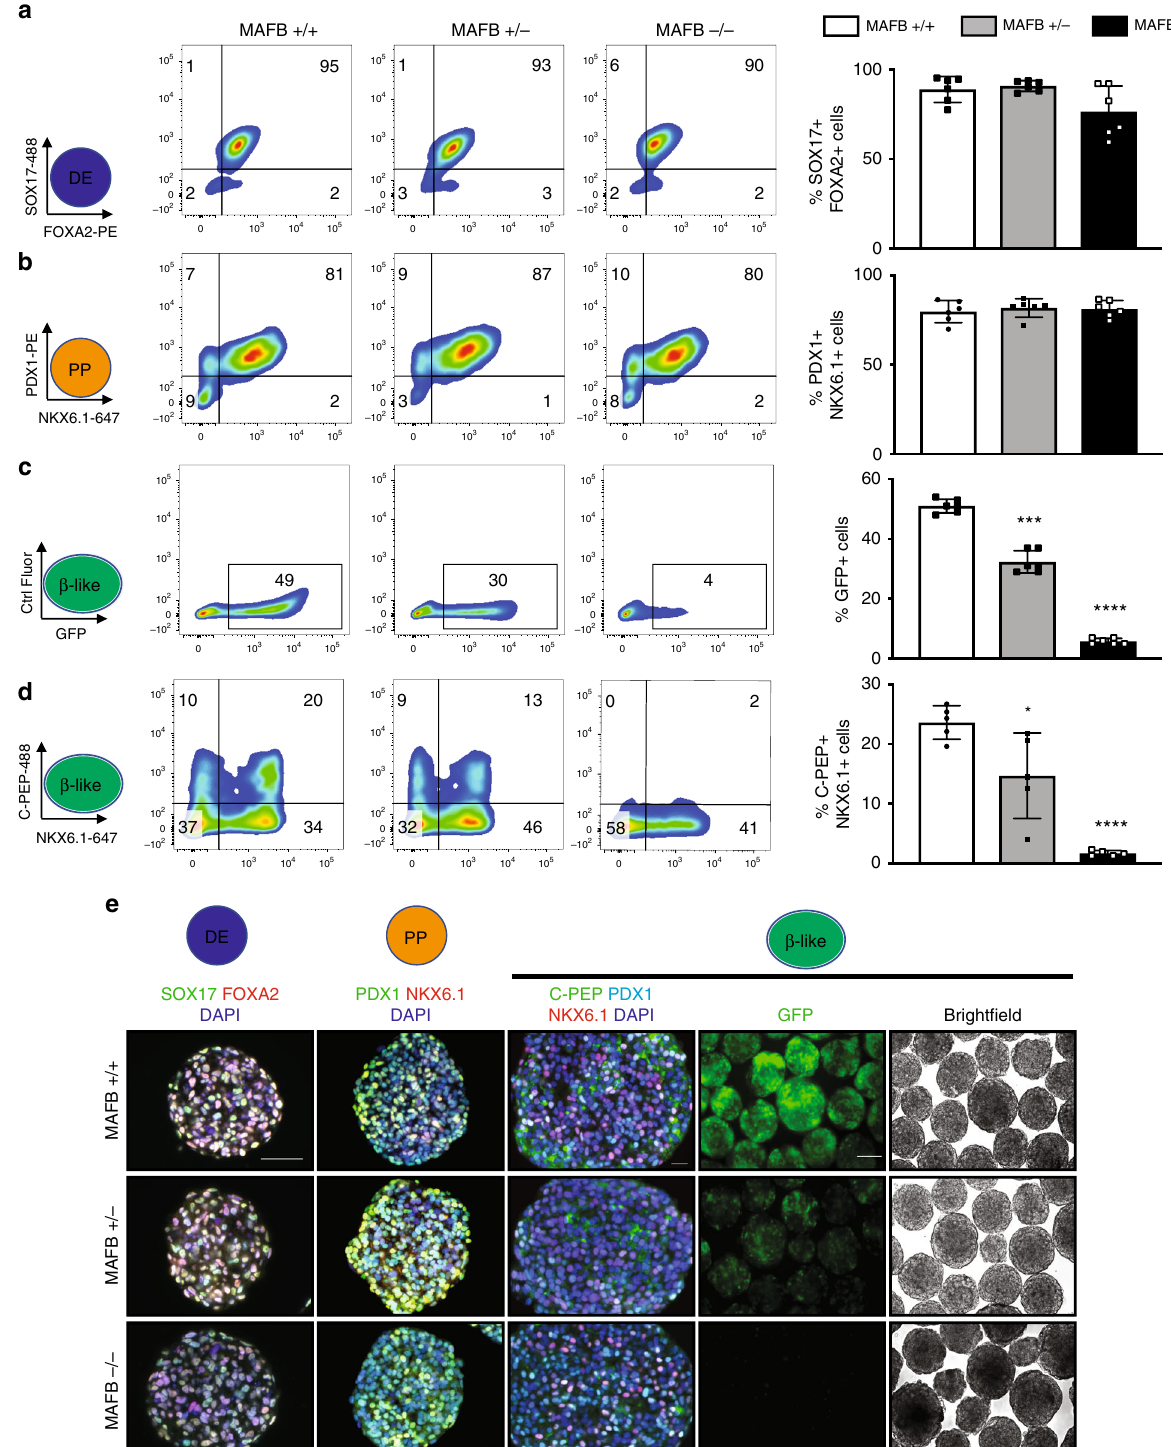
Fig. 2 Loss of MAFB limits β -cell derivation. a Representative FC plots depicting the percentages of SOX17 + FOXA2 + cells and quanti fi cation at the DE stage ( n = 6, biologically independent samples). b Representative FC plots depicting the percentages of PDX1 + NKX6.1 + cells and quanti fi cation at the PP stage ( n = 6, biologically independent samples). c Representative FC plots depicting the percentages of GFP + cells and quanti fi cation at the β -cell stage ( n = 6, biologically independent samples). d Representative FC plots depicting the percentages of C-PEP + NKX6.1 + cells and quanti fi cation at the β -cell stage ( n = 6, biologically independent samples). e Representative IF images from six independent experiments at the indicated stages of differentiation depicting SOX17 and FOXA2, PDX1 and NKX6.1, and C-PEP co-staining with PDX1 and NKX6.1. Scale bars, 50 μ m. GFP and Bright fi eld images from live in vitro cell cultures. Scale bars, 100 μ m. P values by one-way ANOVA followed by Dunnett ’ s multiple comparisons test were * P < 0.05, ** P < 0.01, *** P < 0.001, **** P < 0.0001. Data are presented as individual biological replicates and represent the mean ±